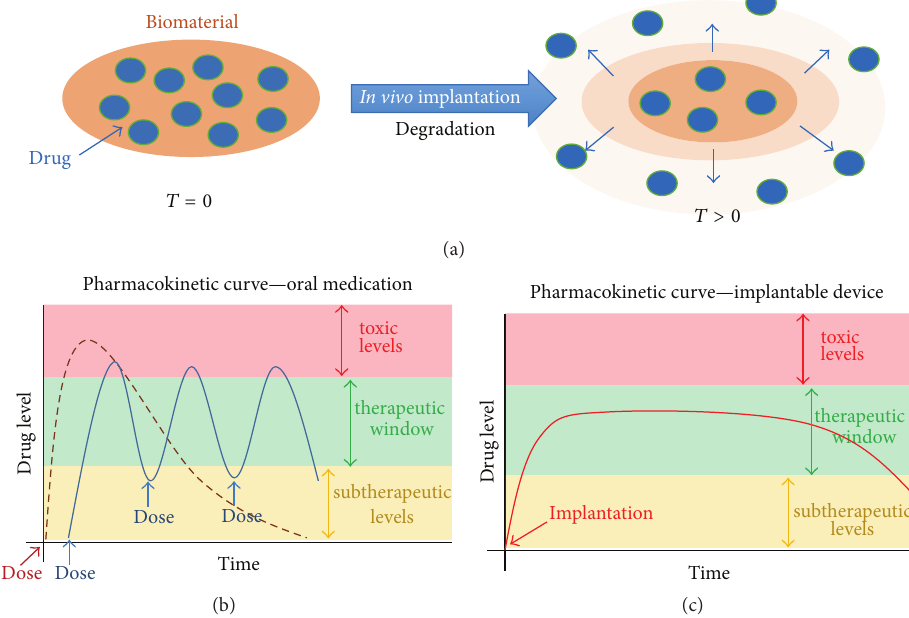
Figure 2: Implantable devices for drug localized delivery. Minimally invasive implantation of drug eluting biomaterials offers advantages over oral drug regimens including localized drug delivery, minimizing or eliminating systemic side effects, and overcoming the barrier of patient noncompliance. (a) Graft implanted biomaterials release active drugs or prodrugs in controlled fashion upon in vivo degradation directly into the local tissue microenvironment. (b) Pharmacokinetic profiles of oral medication versus. (c) Implantable drug eluting materials. Additional advantages include reduced dosing, frequency and duration of dosing, favorable drug kinetics and maintenance of pharmacologic agents within the therapeutic window limiting systemic